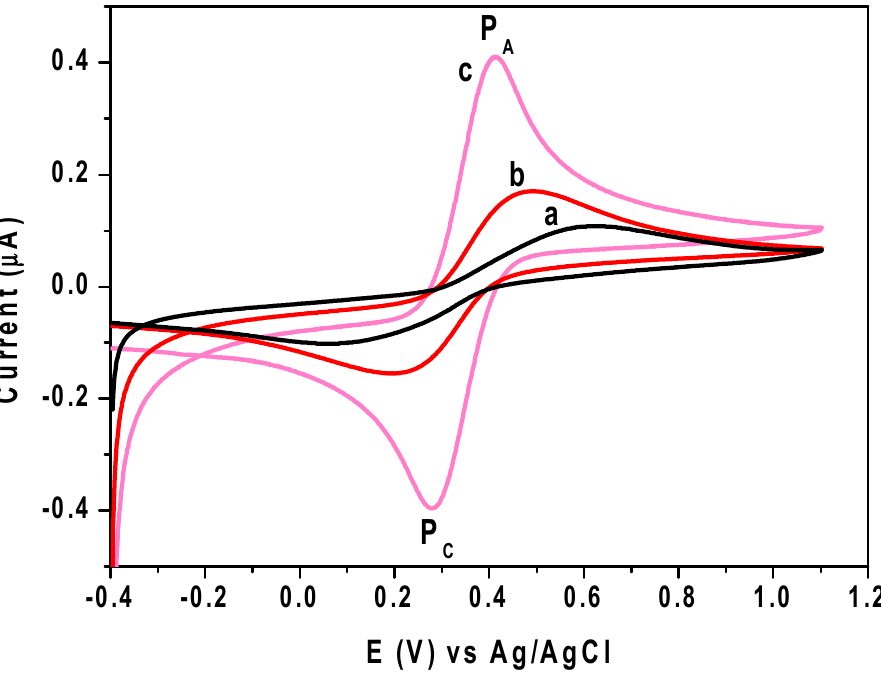
Figure 5. CVs of KCl (0.1 M) contains 1.0 mM of [Fe(CN) 6 ] 3 − /4 − at (a) unmodified CPE, (b) Chs NPs/CPE, and (c) M-Chs NC/CPE with a sweep rate of 50 mV/s.